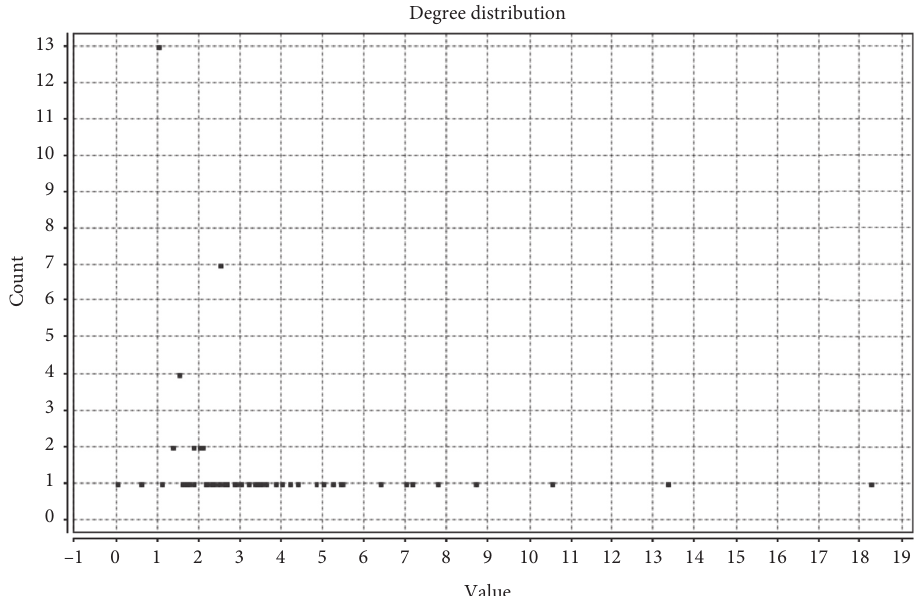
Figure 6: The degree of nodes in the maximum information transmission path.